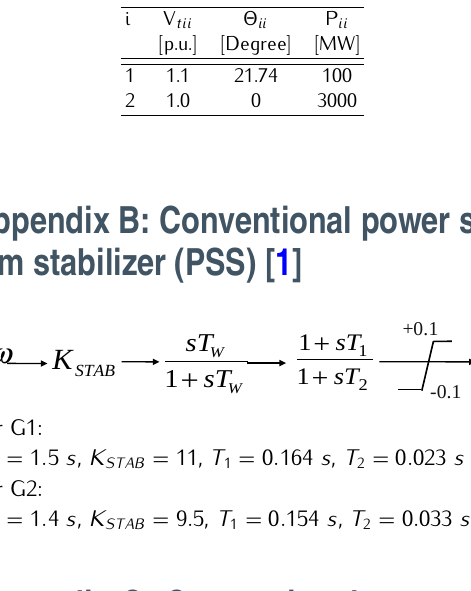
Table 3. Operating conditions of a two-machine system